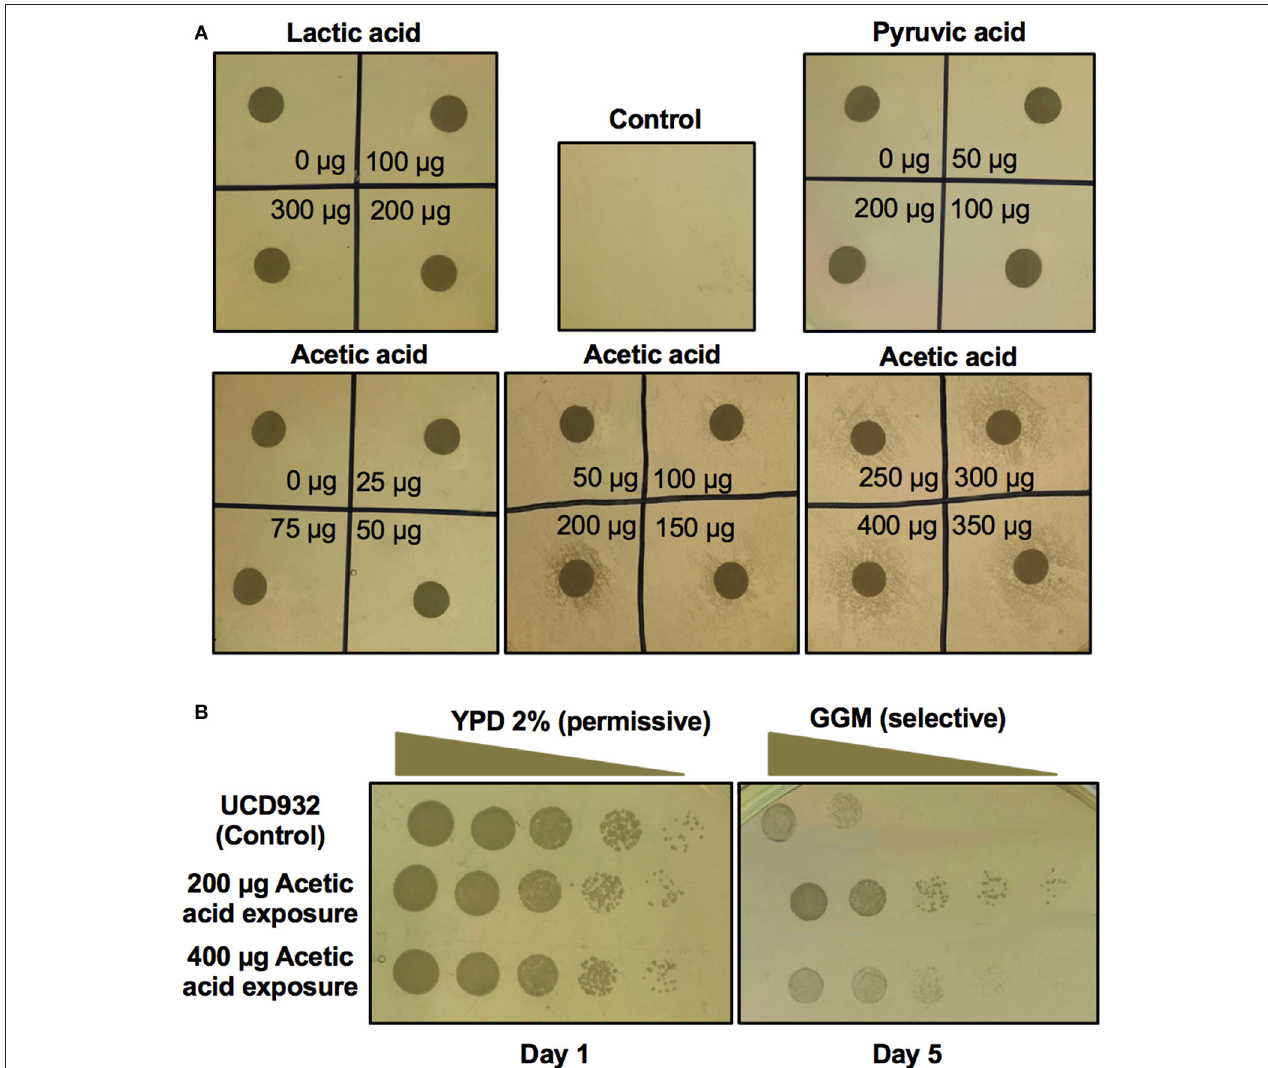
FIGURE 7 | Screen for induction of [ GAR + ] in Saccharomyces strain UCD932 by bacterial metabolites. Growth of active log phase yeast spread plated on GGM plates with varying levels of lactic acid, pyruvic acid and acetic acid spotted in each quadrant show induction of [ GAR + ] by acetic acid but no induction by lactic acid or pyruvic acid (A) . The colonies from around the inducing concentrations of acetic acid retested on GGM after passage through nonselective YPD media show the most stable induction at 200 µ g acetic acid exposure (B) . One replicate of quadruplicate experiments is